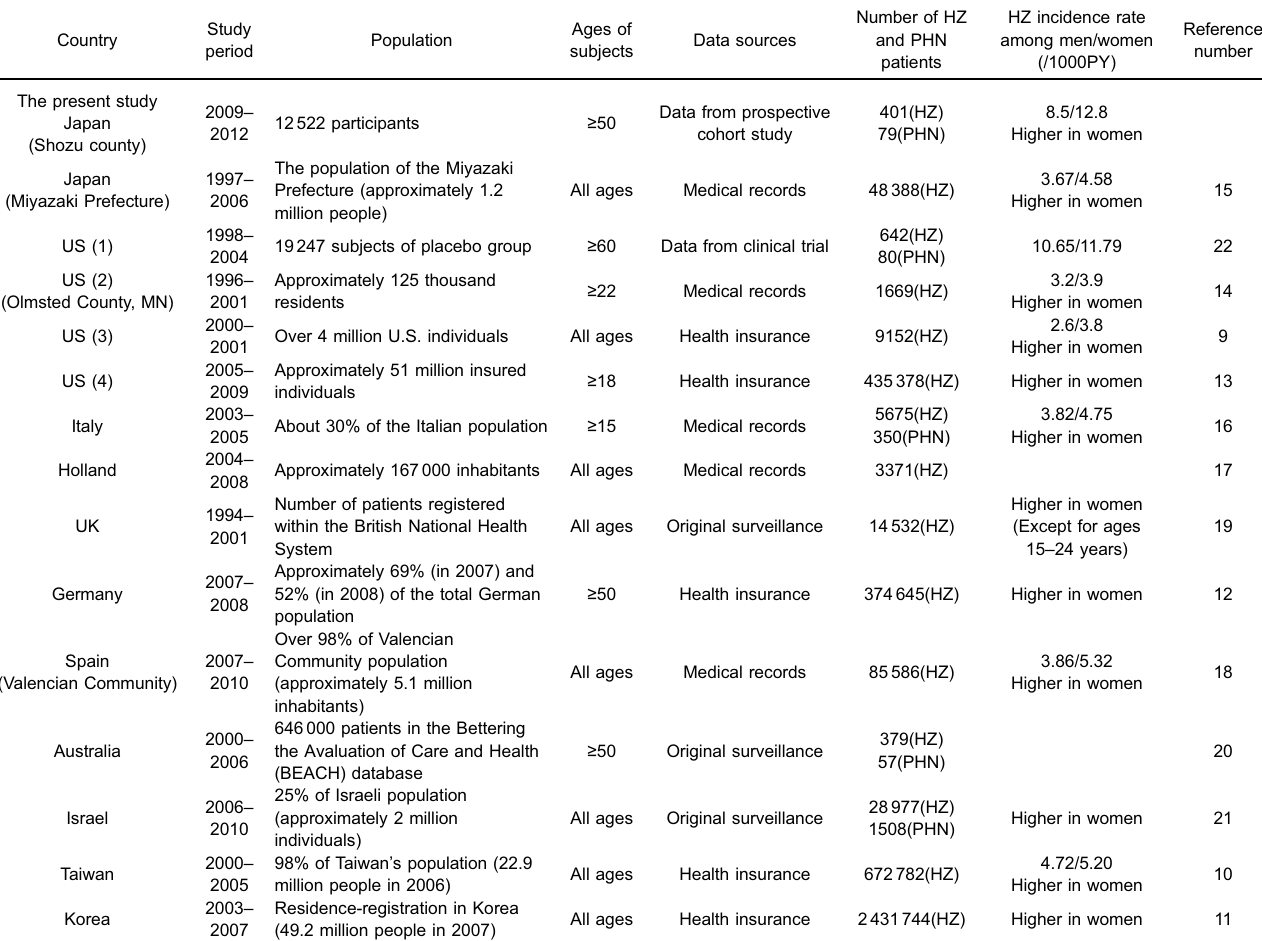
Table 5. Summary of previous studies on the incidence of herpes zoster